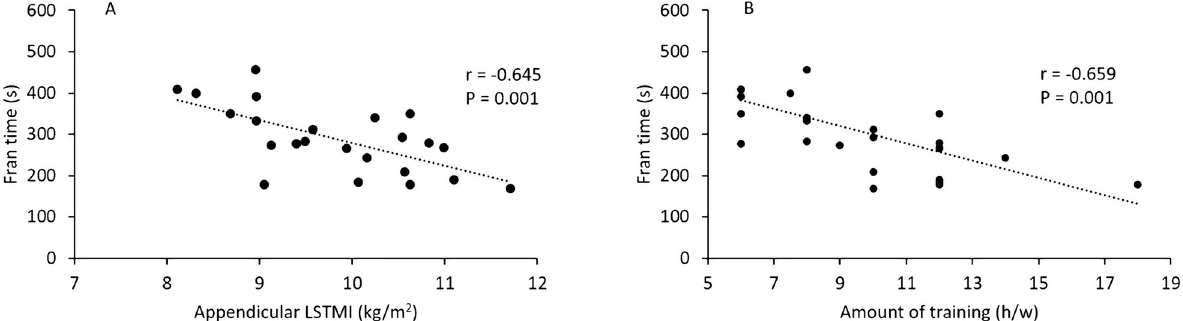
Fig 4. Association between performance in the “Fran” workout and either the amount of Appendicular Lean Soft Tissue Mass Index (LSTMI, Panel A) or the amount of weekly training (Panel B) in CF participants.